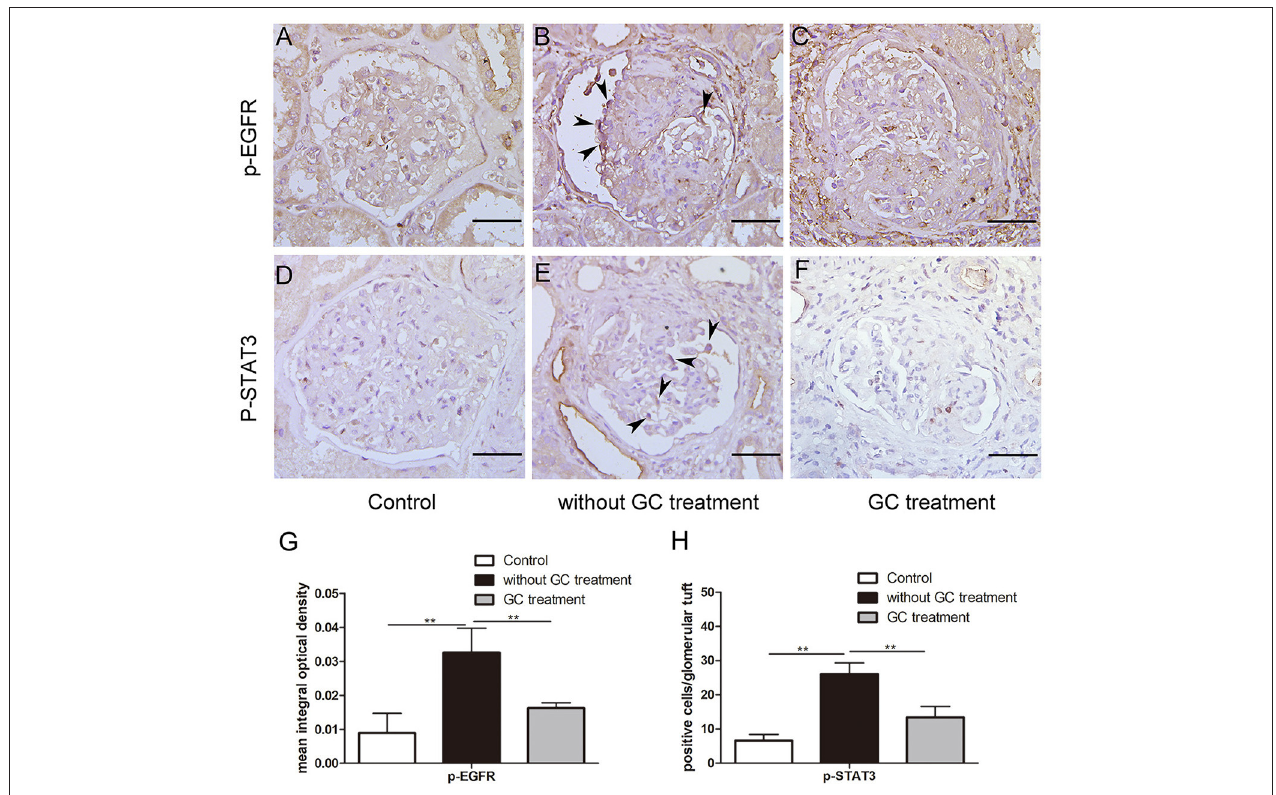
FIGURE 1 | Glucocorticoids inhibited aberrant activation of EGFR-STAT3 signaling in podocytes of patients with anti-GBM nephritis. (A–F) Representative immunohistochemistry staining for p-EGFR and p-STAT3 in sections of kidney biopsies from patients with anti-GBM nephritis. Twenty-two patients who received glucocorticoid (GC) treatment before renal biopsy (C,F) and 12 patients without GC treatment before renal biopsy (B,E) were analyzed. Para-carcinoma kidney tissues (A,D) were used as control. (G,H) Quantification of intensity of IHC staining in glomeruli tuft for a-f. ** P < 0.01 vs. the group without GC treatment. Scale bars, 50 µ